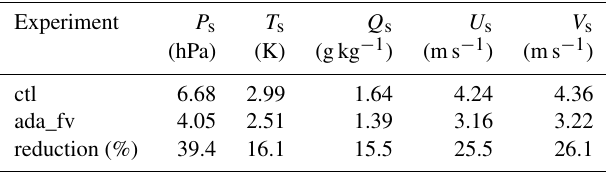
Table 2. Globally averaged RMSEs of surface pressure P s , surface temperature T s , surface specific humidity Q s , surface zonal wind U s , and surface meridional wind V s from ctl and ada_fv. The RM- SEs are calculated with the data of the first month